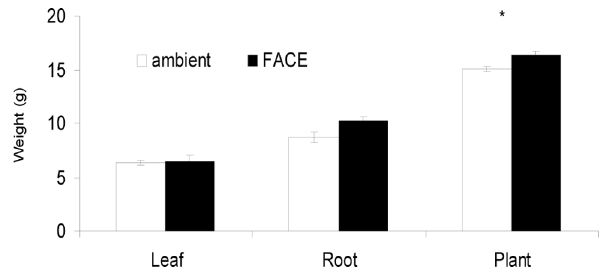
Figure 3. Effects of elevated [CO 2 ] on the content of adenosine in root. Each bar represents the standard error of the difference between treatments ( n =3).